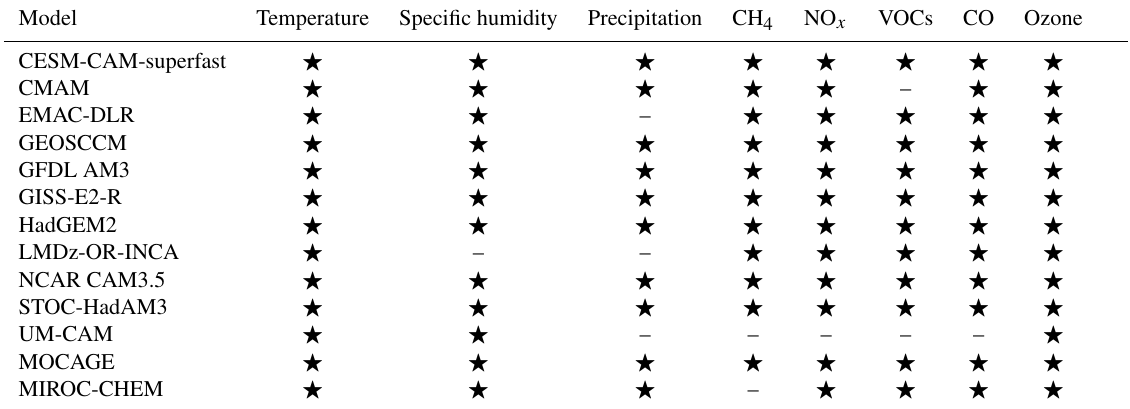
Table 1. List of the historical ACCMIP simulations (2000 time slice) used in this study, and the availability of data for each model and parameter. “ (cid:70) ” indicates “available”; “–” indicates “not available”.